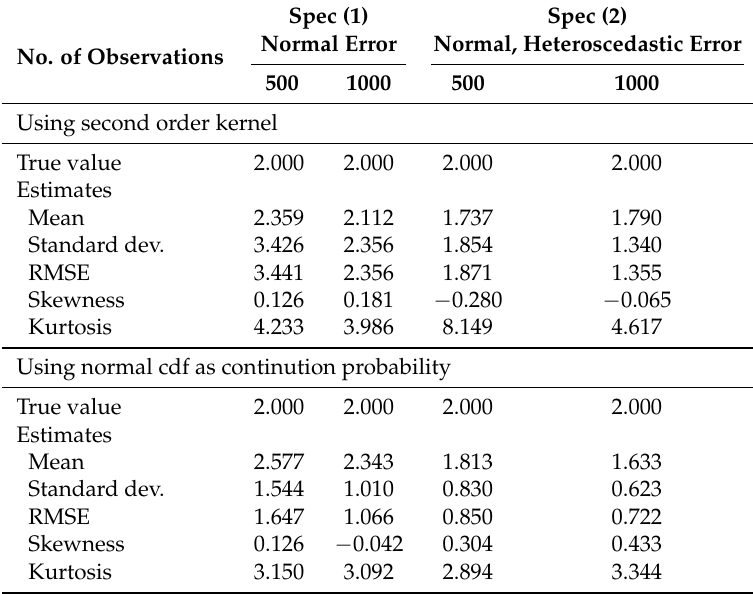
Table 2. Simulation summary statistics—parameter: coefficient on ( s /100 ) .